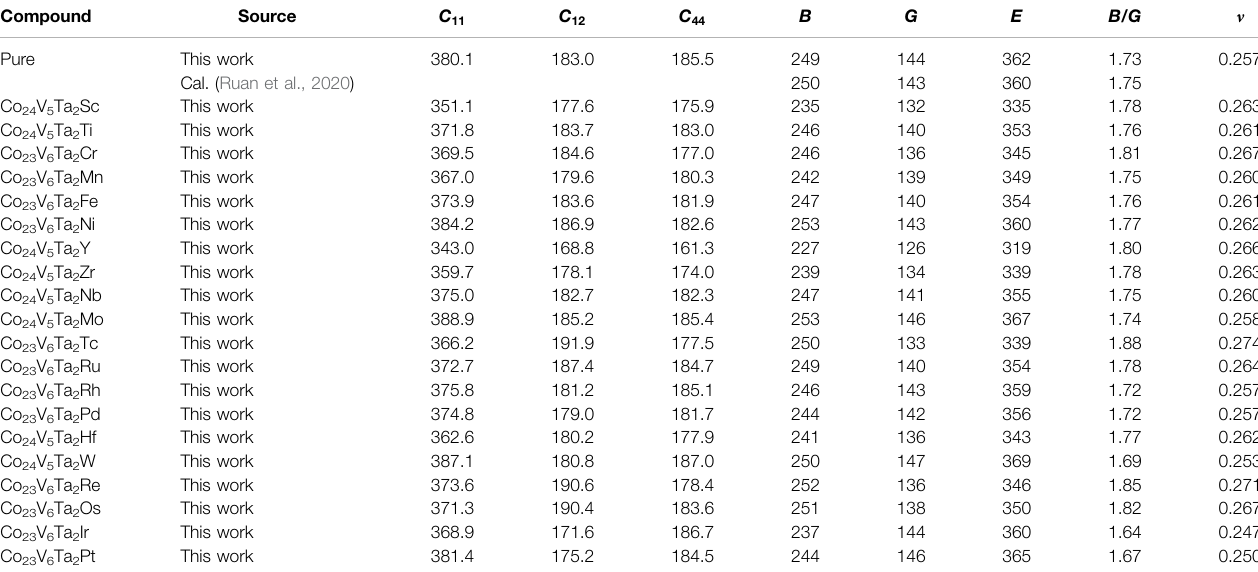
TABLE 2| Elastic properties of γ ′ -Co 3 (V,Ta), including elastic constants C ij ,bulkmodulus B ,shear modulus G ,Young ’ smodulus E ,andPoisson ’ sratio ν .( C ij , B , G ,and E are given by GPa).